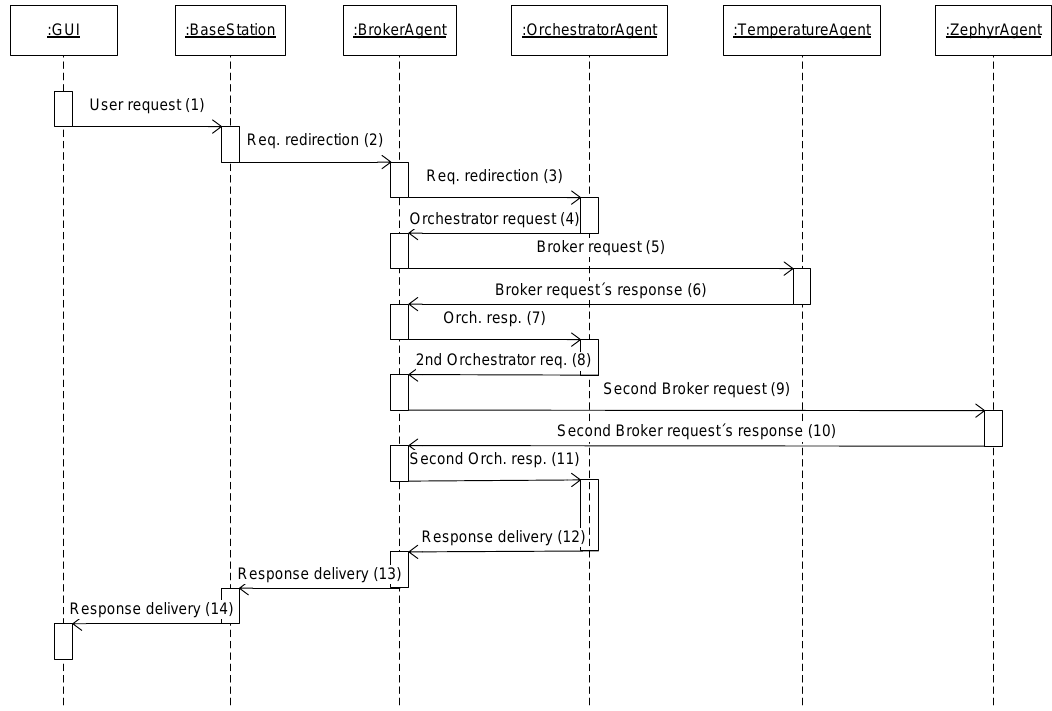
Figure 5. Sequence diagram for a composed